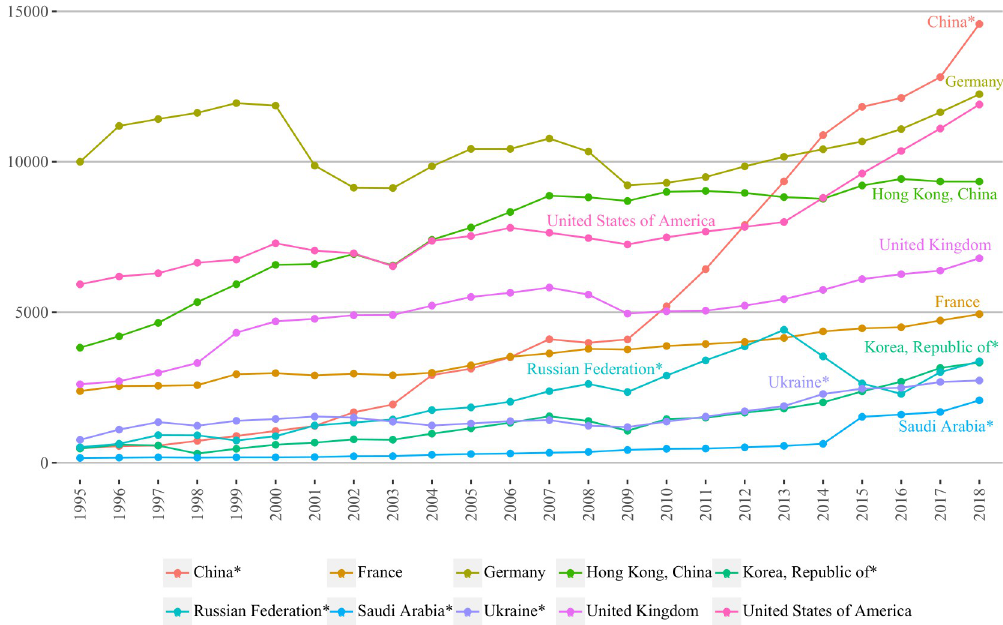
Fig 6. Out-strength centralities of top five BRI and non-BRI countries/regions over 1995–2018. In 10 thousand people; countries/regions are selected based on the highest values of 2018 years; BRI marked with ‘ � ’.